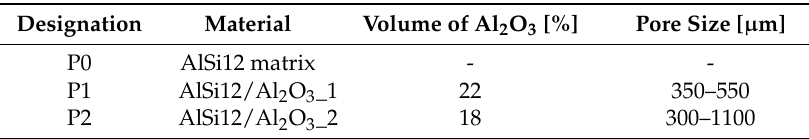
Table 1. Designation of samples used to determine tribological